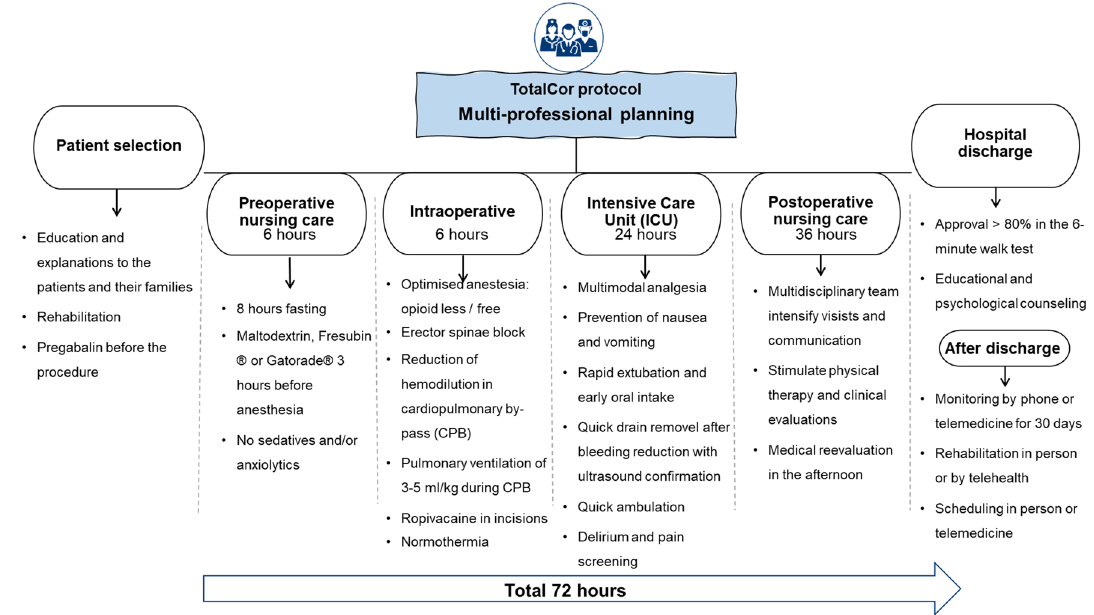
Figure 2. TotalCor protocol flight plan. Visual summary of the TotalCor protocol separated by the hospitalization